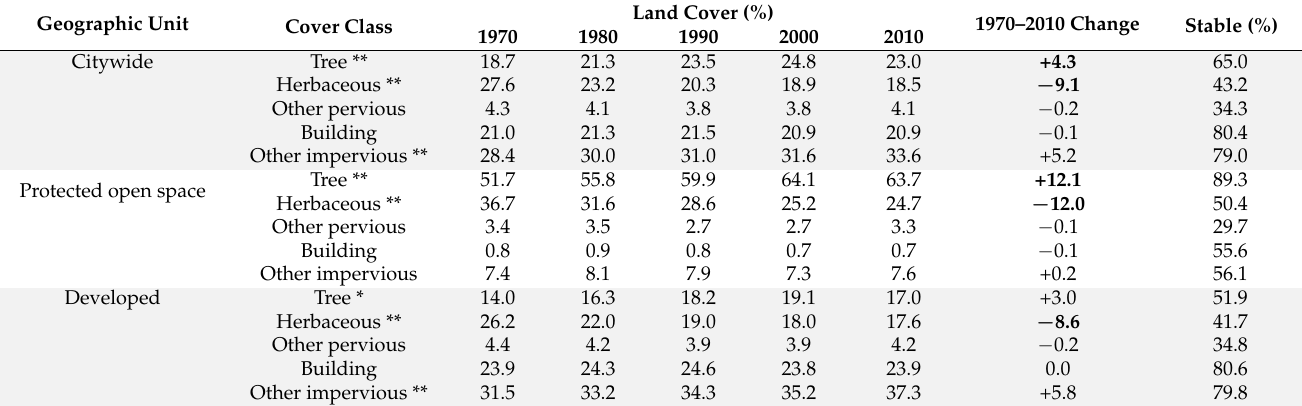
Table 3. Land cover change in Philadelphia, comparing protected open space and developed land. Statistically significant changes from 1970–2010 are noted with * ( p < 0.05) and ** ( p < 0.01). Detectable change over 40 years is noted in bold ( ± 3.2 for tree cover, 4.7 herbaceous, 7.4 other pervious, 1.2 building, and 9.1 other impervious). Percent stable reflects points classified as the same cover class in all five images divided by 1970 cover. Some land cover values in a given year do not sum to 100 due to rounding. Grey shading serves only to enhance readability.